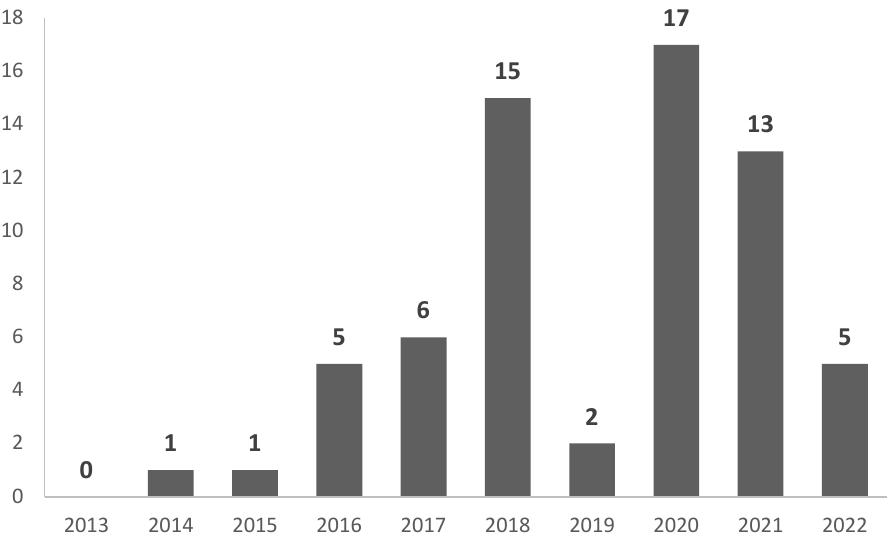
Figure 2. Publication rate of filtered articles on 3DP in architecture.